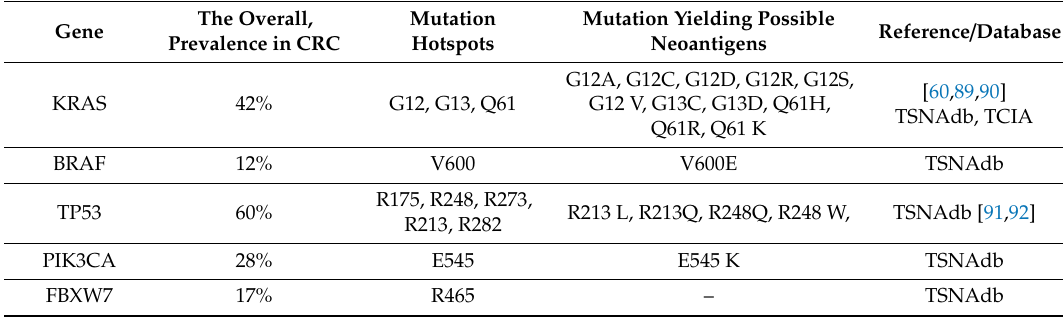
Table 2. Recurrently mutated genes in CRC that may yield potential